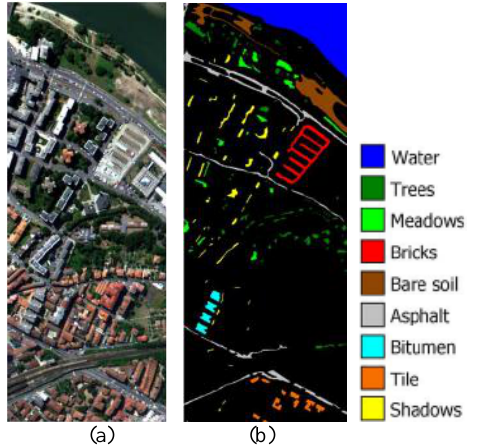
Figure 2. ROSIS Pavia data sets: (a) True color representation and (b) Reference set